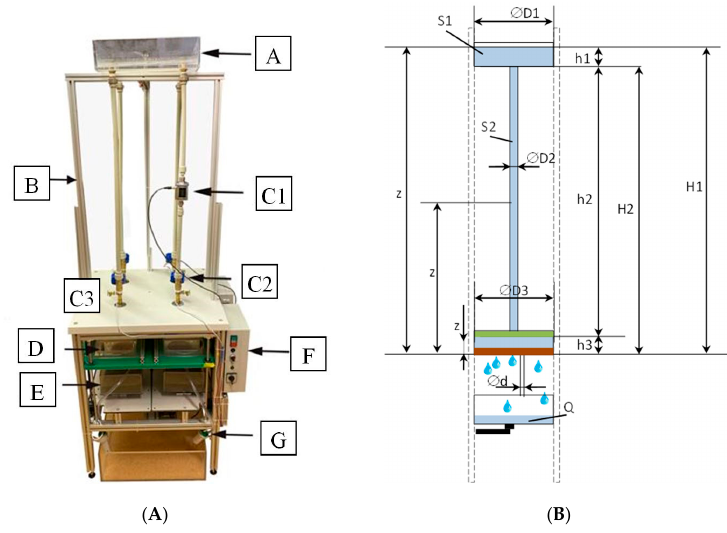
Figure 2. ( A ) HP4 apparatus, ( B ) scheme of hydrostatic pressure on sample.